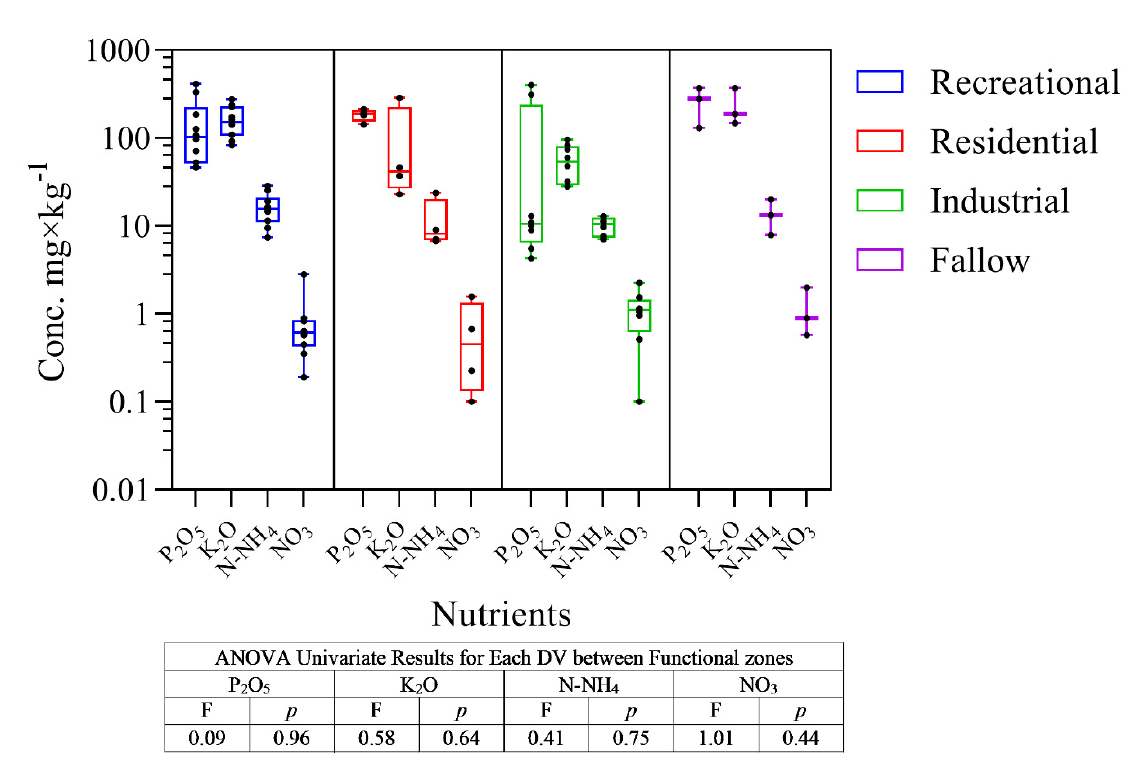
Figure 3. Variation in the content of nutritional elements and the results of statistical data processing.